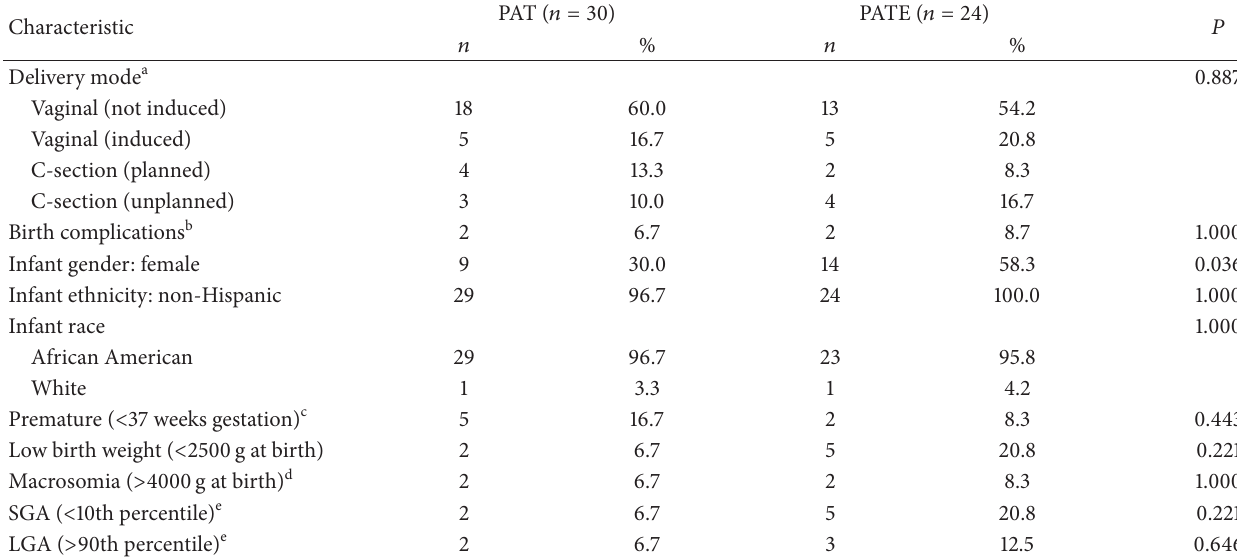
Table 5: Delta Healthy Sprouts participant delivery outcomes and infant birth characteristics by treatment.